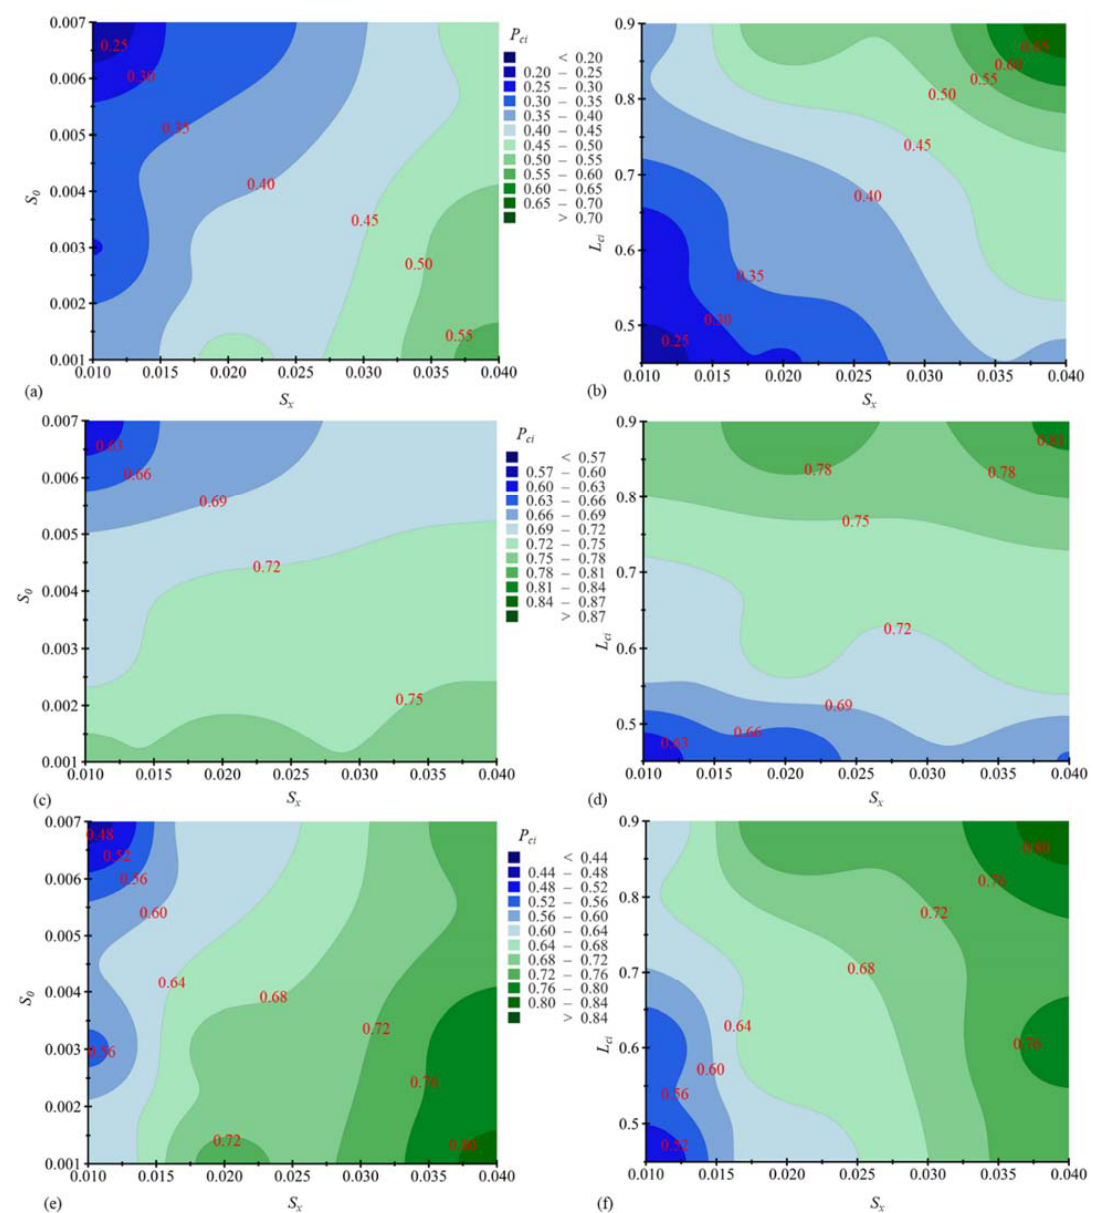
Figure 6. Sensitivity analysis of the percent of runoff volume captured by curb inlet ( P ci ) for the RB stripes with ( a , b ) undepressed curb inlet, ( c , d ) composite depressed curb inlet, and ( e , f ) local depressed curb inlet. P ci is plotted as contours with respect to three parameters: S 0 versus S x on the left and L ci versus S x on the right, color bands for each row have different values.